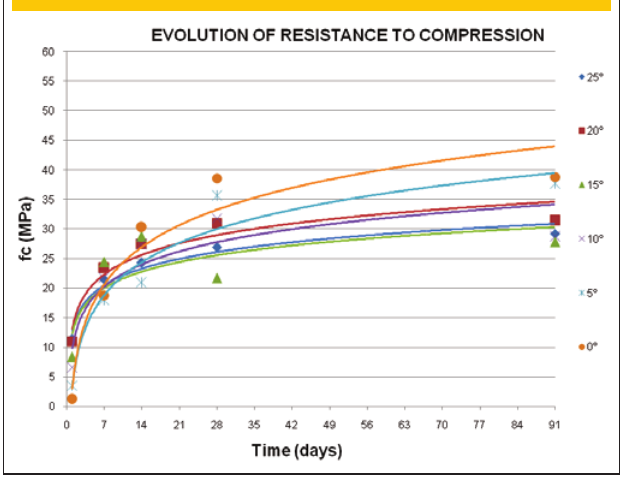
Figure 2 – Evolution of resistance to compression in air-conditioned room (20º C)